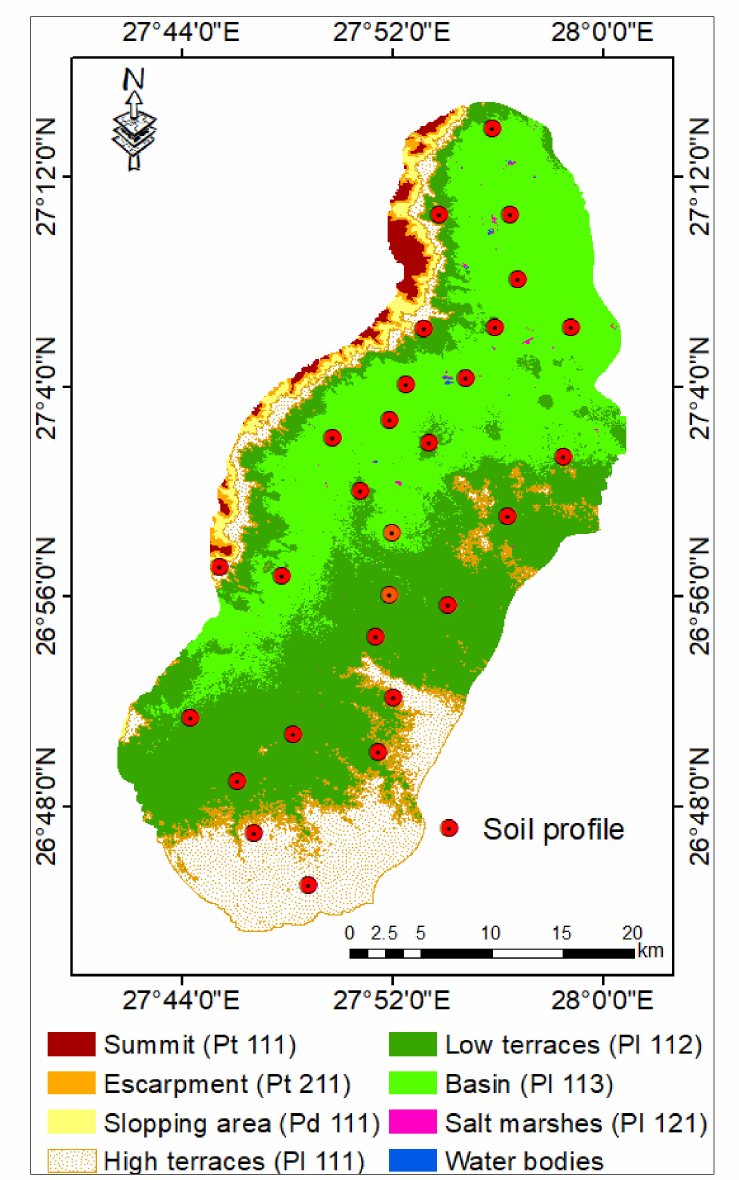
Figure 2. Physiographic units and locations of soil profiles in the studied